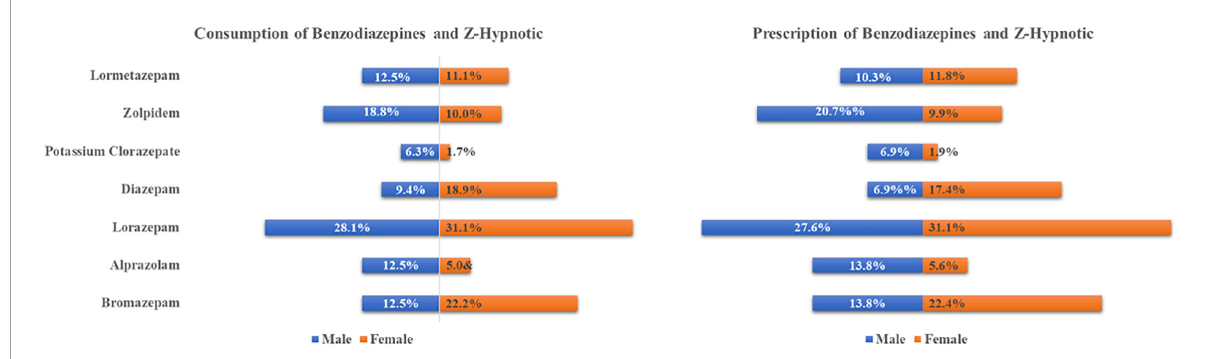
FIGURE1 Prevalence of Benzodiazepine (BZD) and Z-Hypnotic use in patients with long COVID-19 by gender and generic